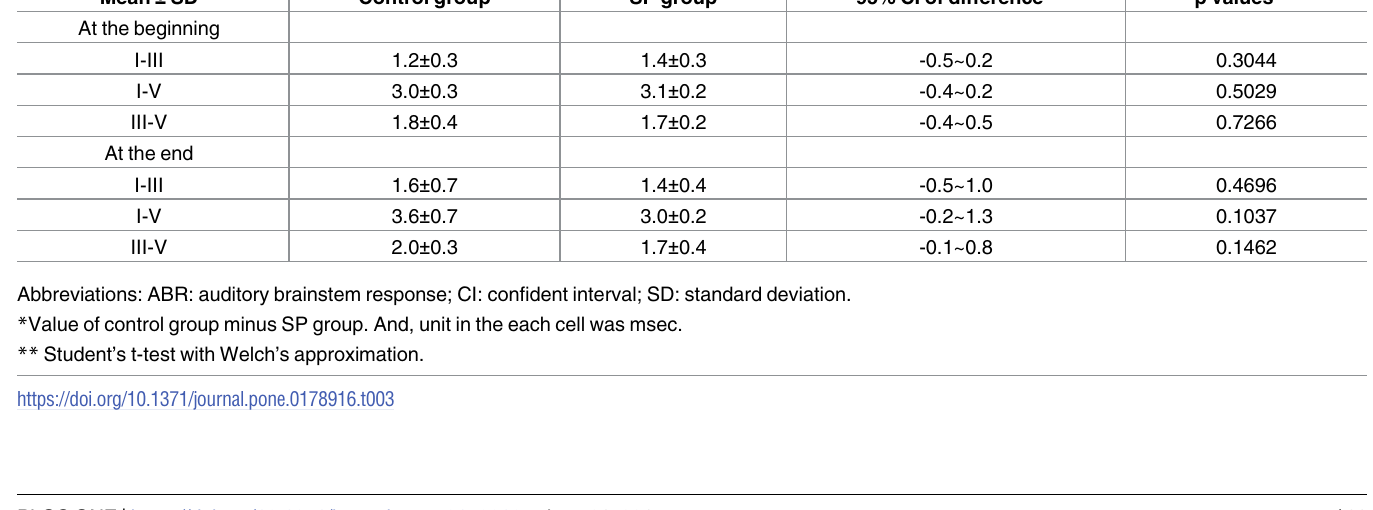
Table 3. ABR intervals by 8k tone burst sound of the both groups at the beginning and the end of this study. Mean ± SD Control group SP group At the